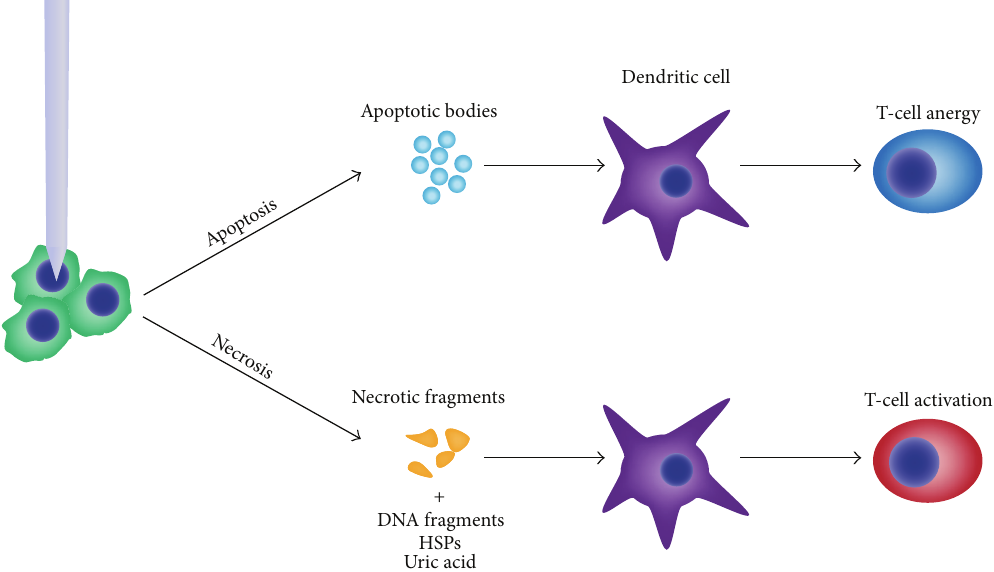
Figure 2: The method of tumor cell death following ablation plays a critical role in the downstream immunologic effects. Apoptosis results in the organized breakdown of dying cells into apoptotic bodies and does not release damage-associated molecular patterns such as DNA, HSPs, or uric acid as is seen with necrosis. Without the subsequent dendritic cell activation, T-cells do not receive costimulatory signals and therefore undergo anergy and clonal